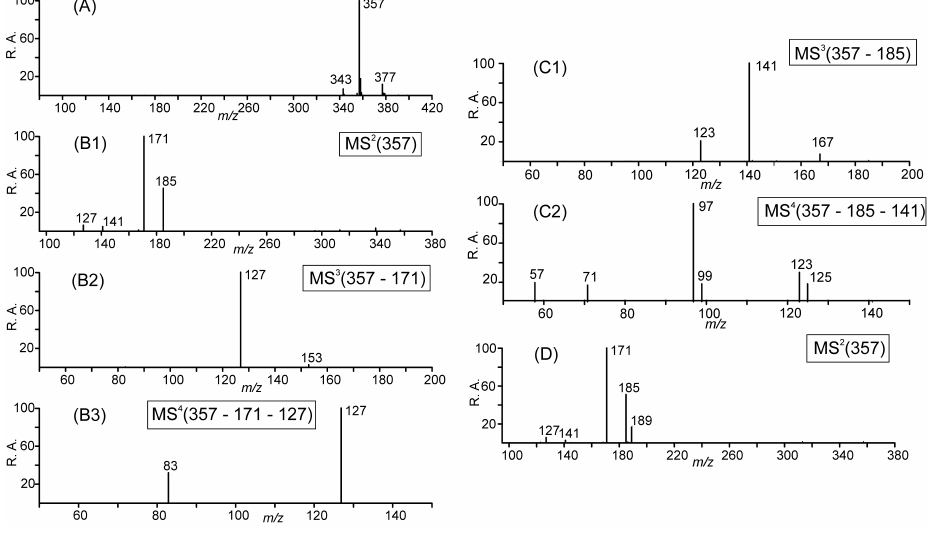
Fig. 6. ( − )ESI-MS data for the relatively abundant MW 358 compound (RT 24.7min; Fig. 1B) present in β -pinene ozonolysis SOA, assigned to a covalent dimer of the ester type: (A) first-order mass spectrum; (B1) m/z 357MS 2 spectrum; (B2) and (B3) m/z 357 → m/z 171MS n ( n = 3 , 4) spectra; and, (C1) and (C2) m/z 357 → m/z 185MS n ( n = 3 , 4) spectra. (D) m/z 357MS 2 spectrum for the weak MW 358 compound at RT 23.0min (Fig.